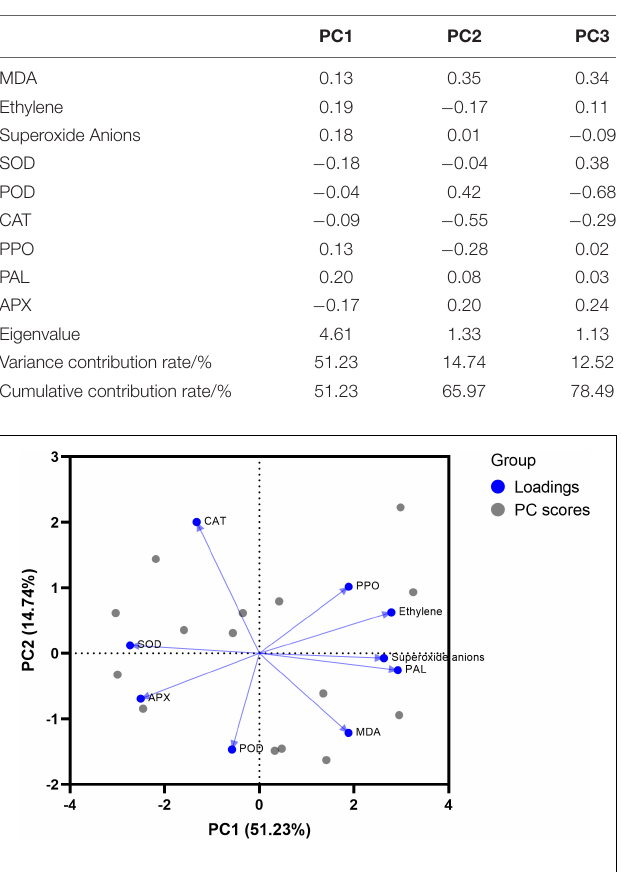
FIGURE 5 | Biplot of principal component analysis of antioxidant system on storage day 10.